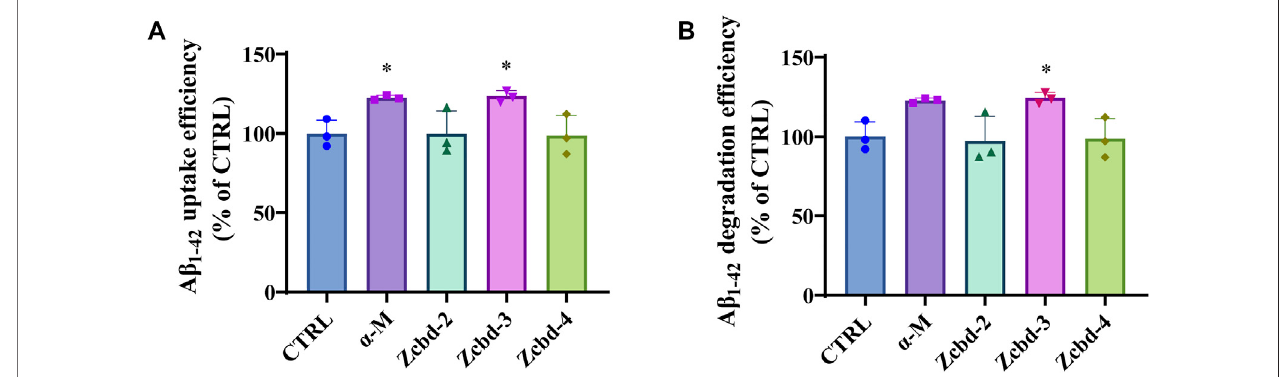
FIGURE 3 | α -M and its analogues enhanced A β uptake and degradation in microglia BV-2 cells (A) The enhancement of A β uptake in microglia by α -M or its analogues.MicrogliaBV-2 cellswerepre-treated with α -M(250 nM)oritsanalogues(100 nM)for24 h.Then A β (1 μ g/ml)wasaddedintothemedium forco-incubation. After 4 h incubation at 37 ° C, the medium was collected to extract the supernatant by centrifugation. The amount of A β in the supernate was detected (B) The acceleration of A β degradation in microglia by α -M or its analogues. BV-2 were pre-treated with α -M (250 nM) or its analogues (100 nM) for 24 h. Then A β was added into the medium for co-incubation. After 4 h incubation at 37 ° C, both the medium and the cell suspension were collected. Moreover, the amount of A β in the medium and cell lysate was detected, respectively. The degradation of A β was evaluated by measuring the difference between the initial total A β and the rest A β both in the medium and lysis of BV-2. All data represent mean ± SEM from 3 independent experiments. p p < 0.05 compared to the control group (CTRL).